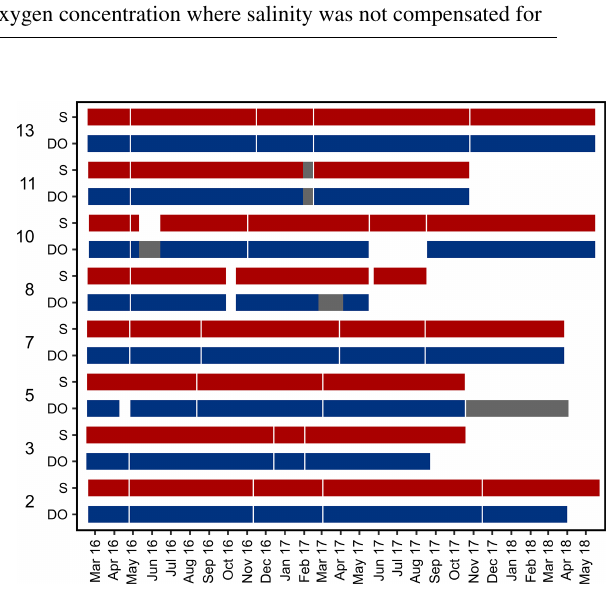
Figure 4. Data availability of dissolved oxygen (DO) concentration and salinity measured by self-contained data loggers. Both logger types (DO and salinity) additionally measured temperature. Tem- perature data are always available for the same periods as DO and salinity. Grey bars indicate cases where only temperature data are available. Y axis shows station numbers and respective logger type. Note that only data with a quality flag of 1 are